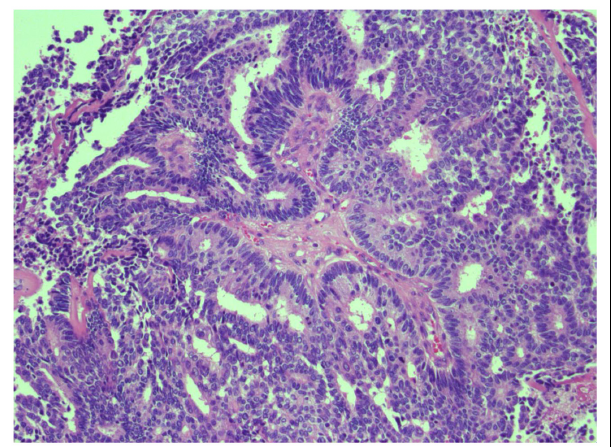
FIGURE 1 | H & E stain of poorly differentiated prostate cancer . Representative image of high-grade prostate carcinoma from the cystoprostatectomy specimen exhibiting cribriform pattern and cell necrosis.